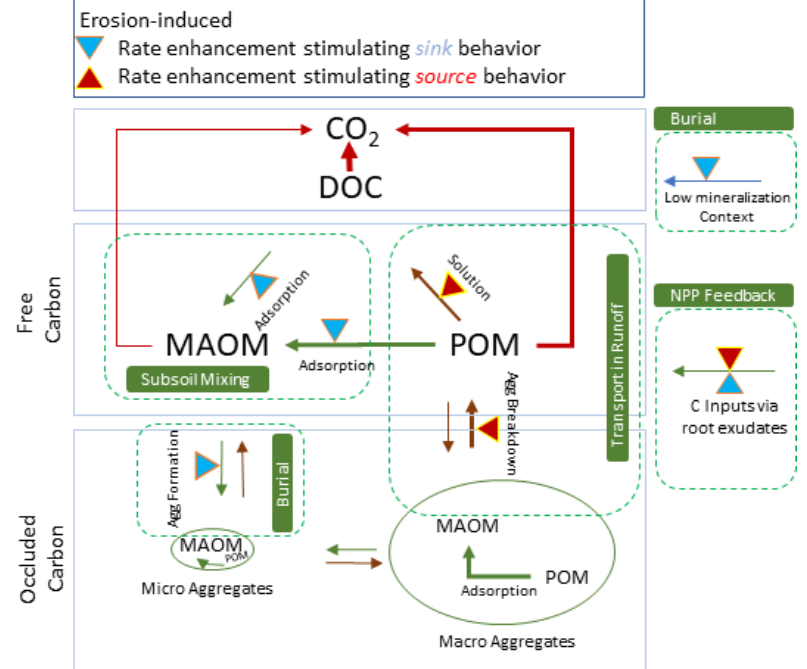
Figure 1. Schematic representation of the effect of water erosion and deposition on soil OC stabilization and loss processes. Transport in runoff: detachment and transport can shift OC from a protected state in aggregates to an available state where it mineralizes more rapidly. Burial: the deposition of eroded OC moves OC into a low-mineralization context and can also enhance protection via aggregation. Subsoil mixing: at sites of erosion new OC formation from new vegetation inputs into exposed subsoil by erosion may replace some of the eroded OC. Net primary production (NPP) feedback: erosion and deposition may affect the nutrient and soil depth status (and hence soil fertility) as well as the environmental factors that control OC input versus output.